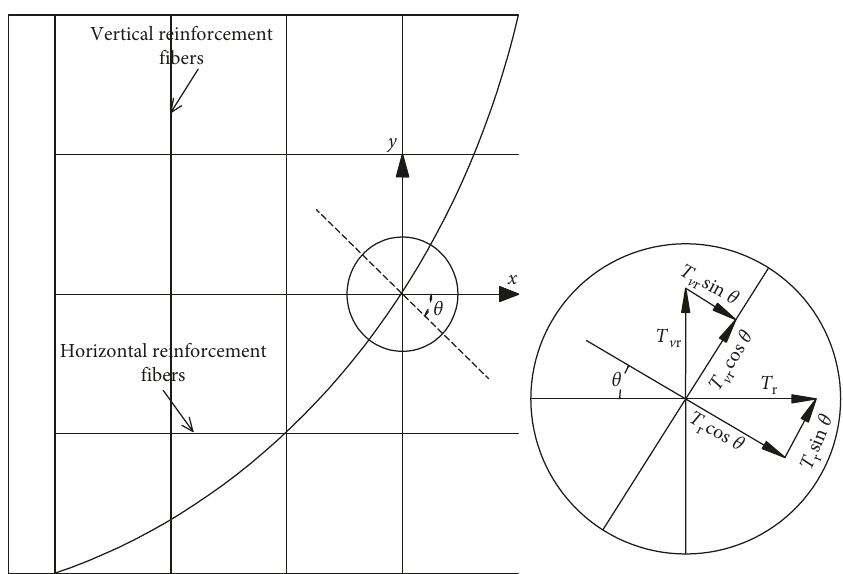
Figure 12: Schematic diagram of the horizontal-vertical